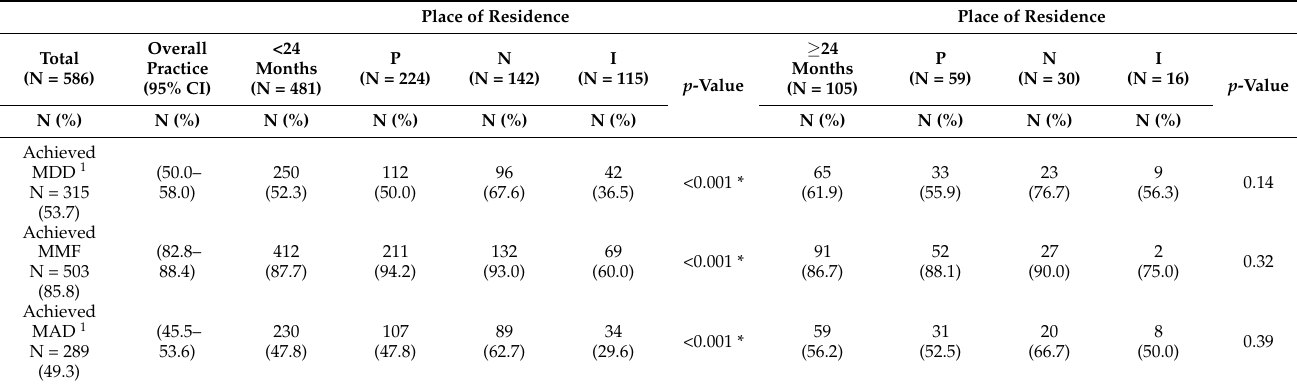
Table 4. Minimum dietary diversity (MDD), minimum meal frequency (MMF), and minimum acceptable diet (MAD) according to the place of